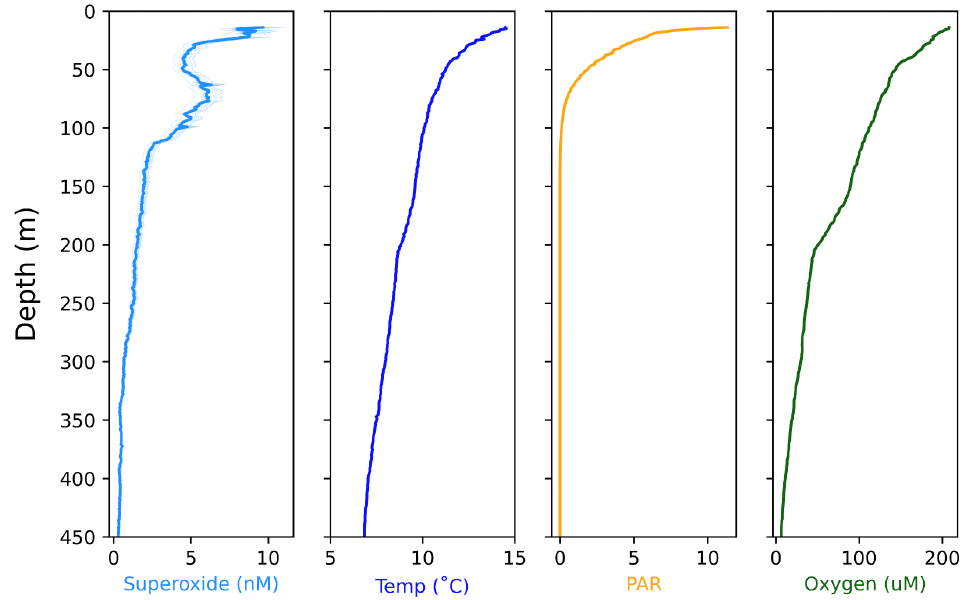
Figure 10. The O – 2 concentrations with depth for Cast 4, in comparison with temperature, PAR, and oxygen data from the